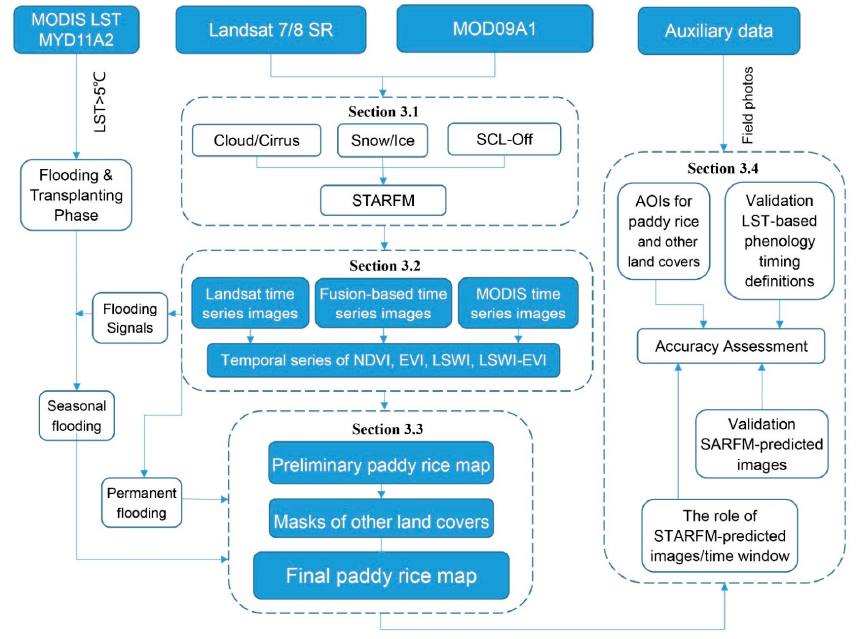
Figure 6. Overview of the methodology for fusion-and phenology-based paddy rice mapping using the Landsat data, MODIS data and other ancillary data.